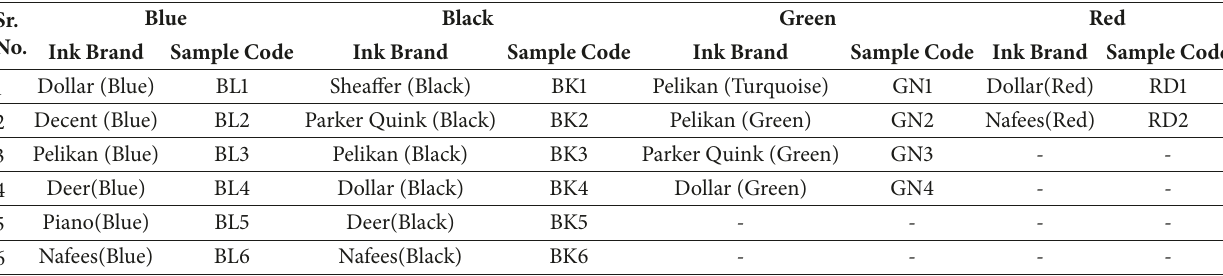
Table 1: Sample of fountain pen inks of different colors and brands.